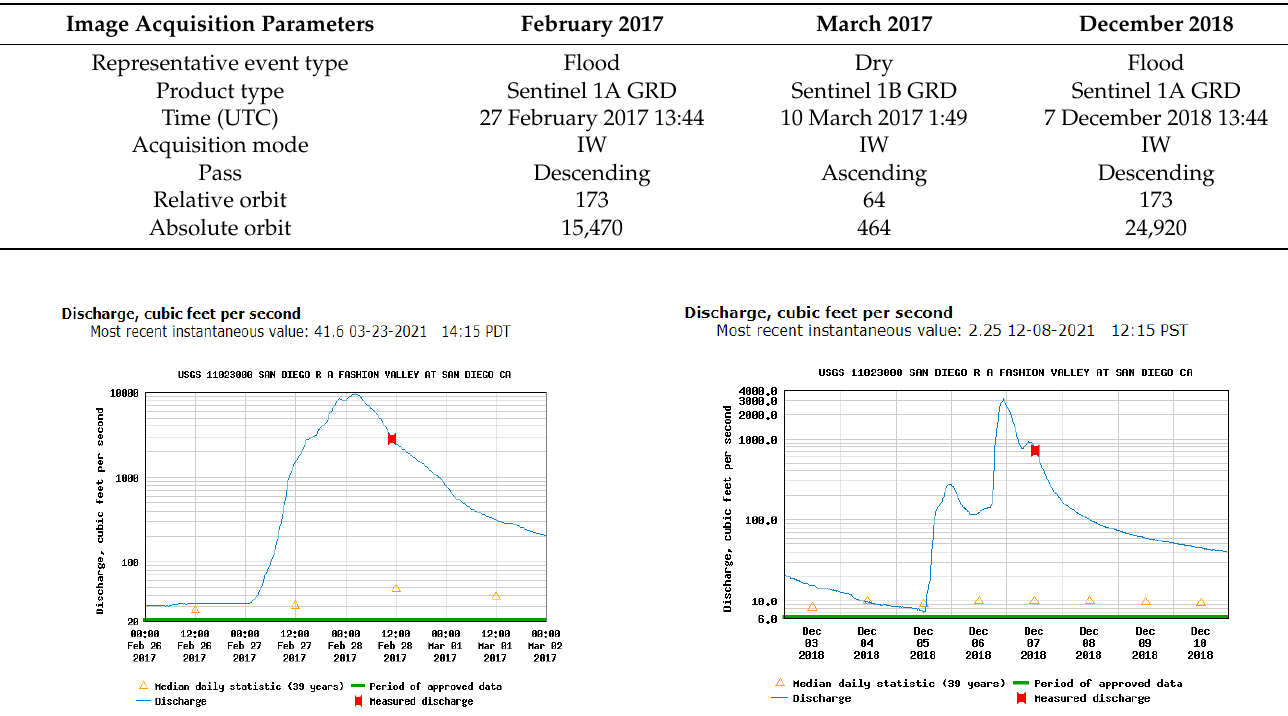
Figure 4. Image acquisition time marked as red points on the flood hydrograph for wet scenes. Left: